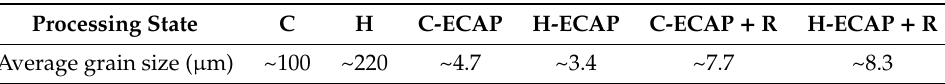
Table 2. Estimated average grain sizes of AZ91 alloys at di ff erent processing